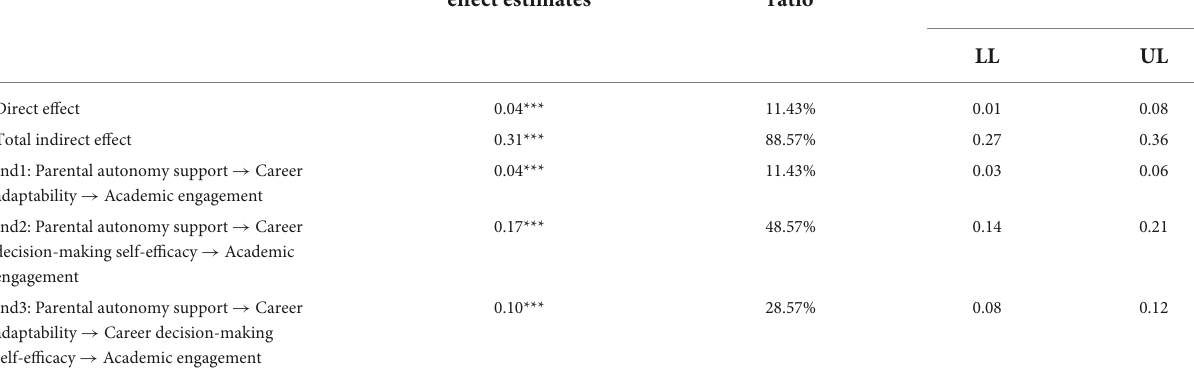
TABLE 3 Results of intermediate effect